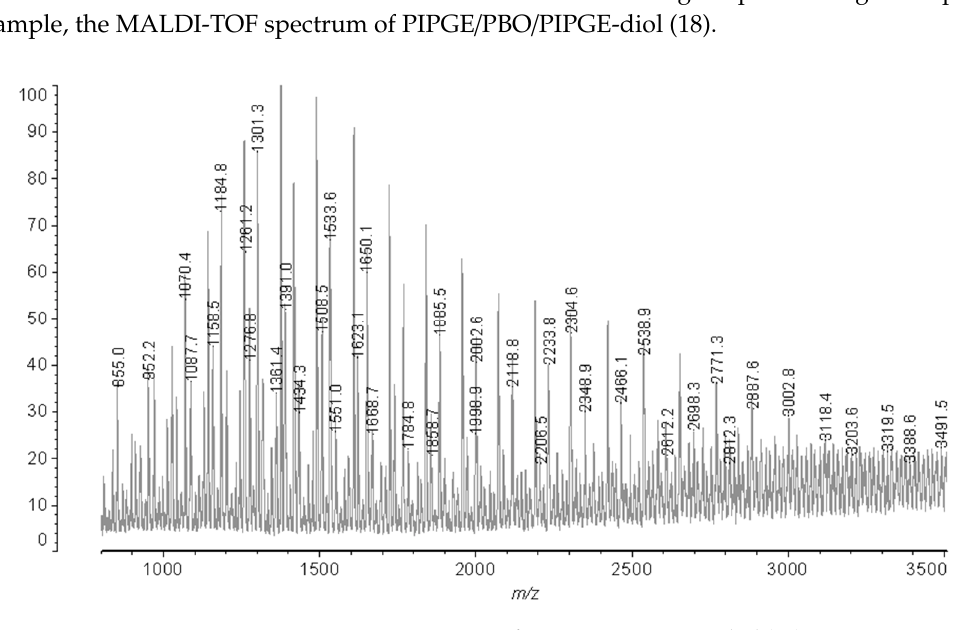
Table 4. Composition of PIPGE/PBO/PIPGE triblock copolyether-diol (18) determined by MALDI- TOF mass spectrometry.